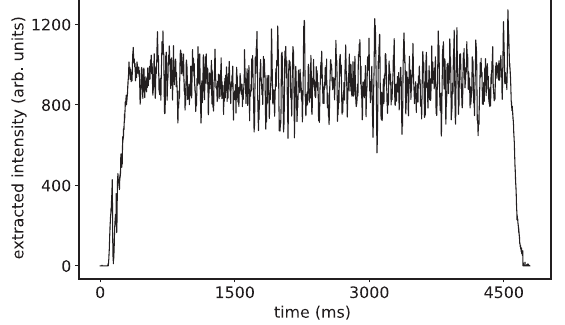
FIG. 13. Randomly chosen slow extracted proton spill to the North Area with COSE (4th of November, 2018).